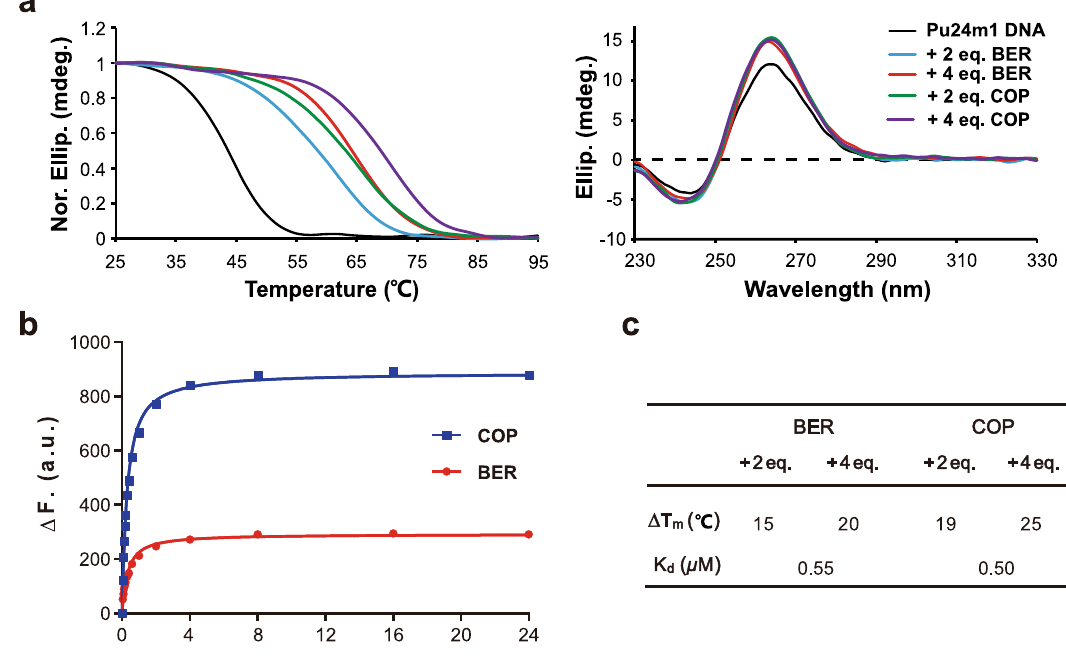
Fig. 2 | Biophysical characterization of berberine and coptisine binding to the KRAS -G4. a CD thermal melting curves and CD spectra of Pu24m1 DNA with ber- berine and coptisine, respectively. Conditions: 20 μ M DNA, pH 7, 15mMK + solu- tion. b Fluorescenceintensitychangeofberberineandcoptisineupontitrationwith Pu24m1 DNA, respectively. Conditions: 0.2 μ M compound, pH 7, 50mMK +